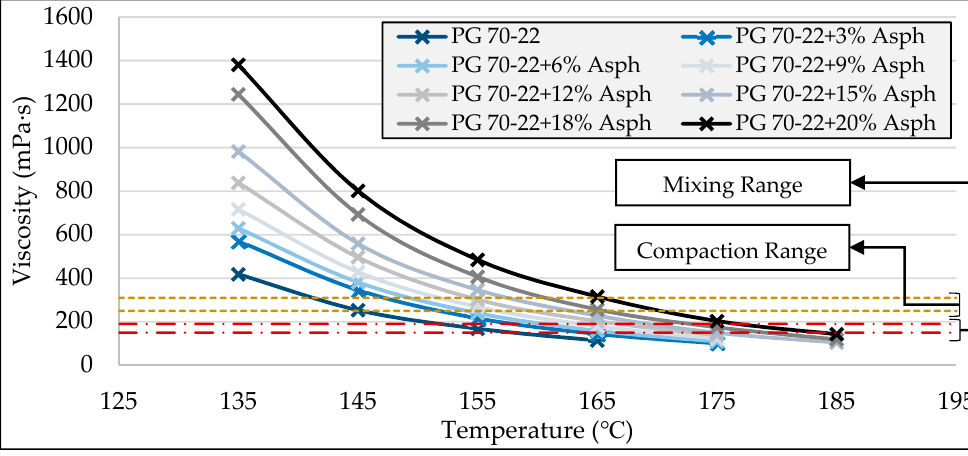
Table 3. Mixing and compaction temperature range of base and asphaltenes-modified binders.